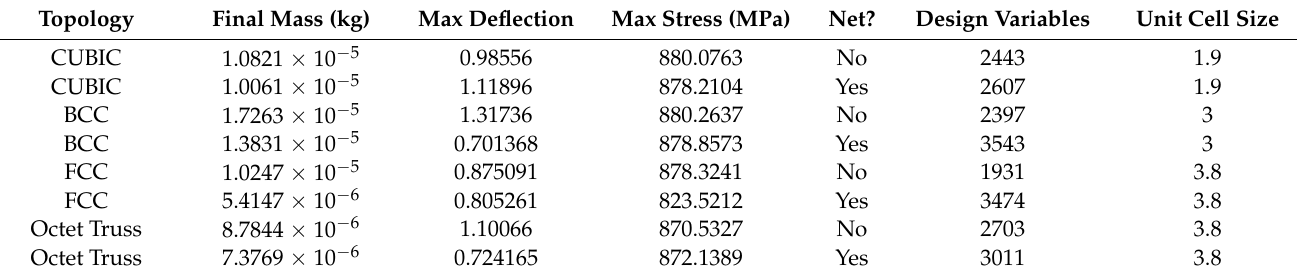
Table 2. Lattice net case study